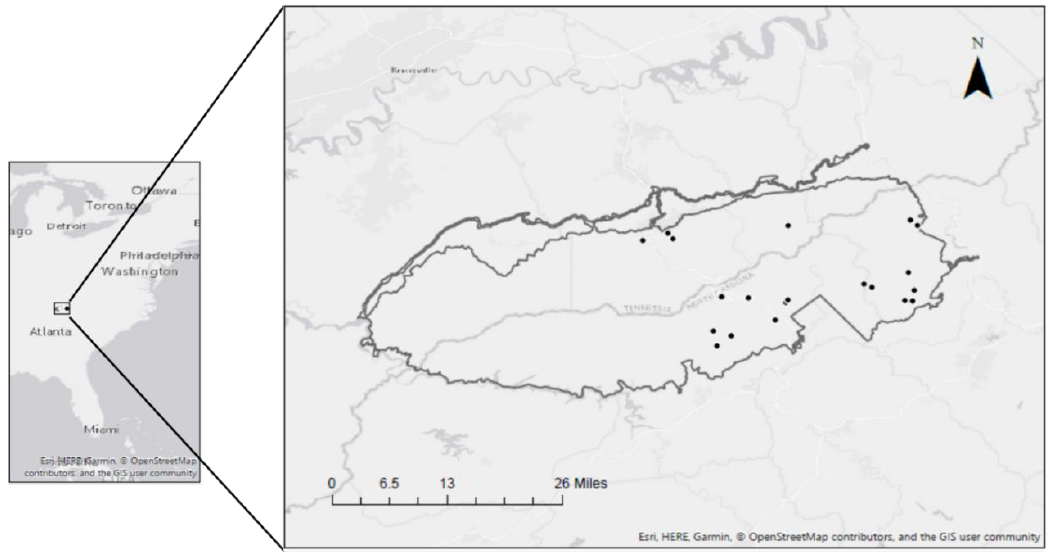
Figure 1. Map of Great Smoky Mountains National Park showing locations of vegetation monitoring plots sampled in 2003 and 2016 / 2017. Plots were established in clusters of three and some individual plots are not distinguishable at this scale.